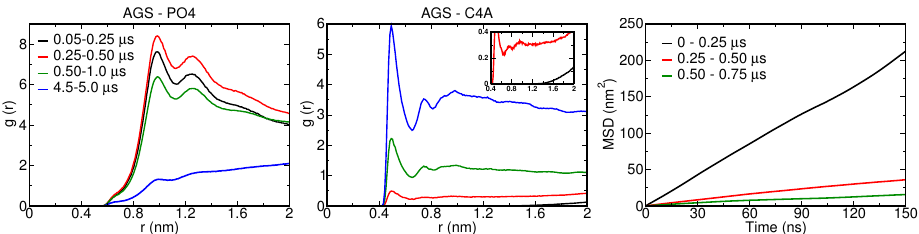
Figure 11. (left and middle) Radial distribution functions (g(r)) of AGS with PO4 (left) and C4A (right) CG beads averaged over various timescales. Here AGS, PO4 and C4A CG beads represent the 10 nm Ag CG NP shell and lipid head, while the C4A CG beads are the terminal CG bead of the DPPC, DOPC and POPC lipids tails. (right) Mean square displacement vs. time for CG water within 0.5 nm of the Ag CG NP surface averaged over different time